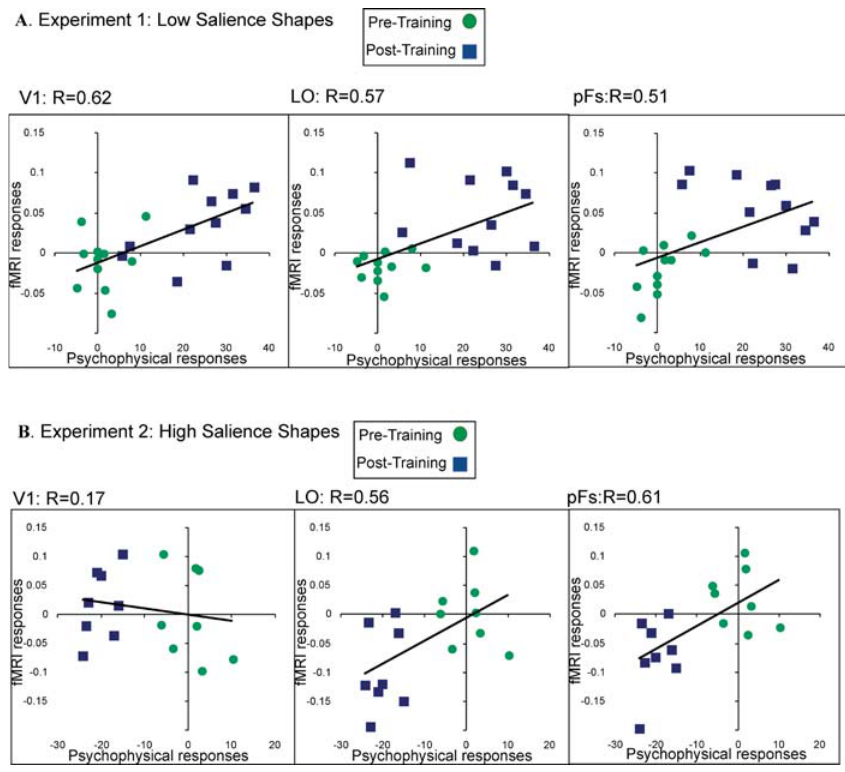
Figure 6. Relationship between Psychophysical and fMRI Learning Effects fMRI data and the corresponding psychophysical response for low-salience (A) and high-salience (B) shapes. For each individual subject, we plotted a behavioral learning index (percent correct for trained minus percent correct for untrained stimuli) and an fMRI learning index (percent signal change for trained minus percent signal change for untrained stimuli) after training. Positive values indicate stronger responses for trained than untrained shapes, whereas negative values indicate lower responses for trained than untrained shapes. For low-salience shapes the regression analysis was significant in early visual areas (V1: r = 0.62, F 1,21 = 13.65, p = 0.001; V2: r = 0.42, F 1,21 = 6.65, p , 0.05; Vp: r = 0.50, F 1,21 = 7.62, p = 0.01; V4: r = 0.50, F 1,21 = 8.91, p , 0.01) and the LOC subregions (LO: r = 0.57, F 1,21 = 9.84, p , 0.01; pFs: r = 0.51, F 1,21 = 7.18, p = 0.01). For high-salience shapes the regression was significant only in the LOC subregions (LO: r = 0.56, F 1,15 = 6.69, p , 0.05; pFs: r = 0.61, F 1,15 = 8.58, p = 0.01) but not in the early visual areas (V1: r = 0.17, F